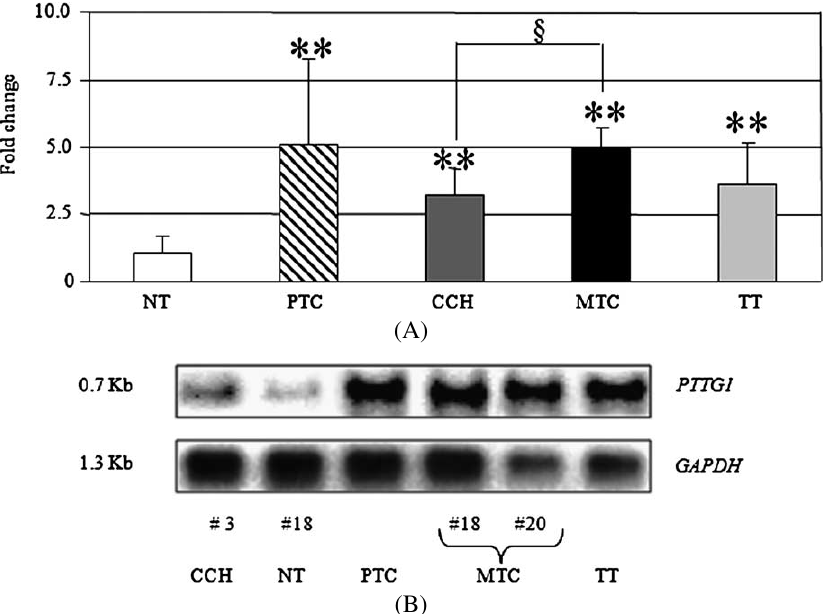
Fig. 1. Northern blot analysis of PTTG1 gene expression. (A) Northern blot analysis for PTTG1 mRNA expression in normal thyroid tissue (NT), 4 PTC, 8 CCH, 19 MTC and TT cells, expressed as fold changes vs. NT ± SE. ∗∗ p < 0 . 01, PTTG1 mRNA expression vs. NT; § p < 0 . 05, PTTG1 mRNA expression in CCH vs. MTC. NT – normal thyroid; PTC – papillary thyroid carcinoma; CCH – C-cell hyperplasia; MTC – medullary thyroid carcinoma; TT – TT cell line. (B) PTTG1 mRNA levels. Representative Northern blot analysis for PTTG1 and GAPDH expression in C-cell hyperplasia (CCH), normal thyroid (NT), papillary thyroid carcinoma (PTC), medullary thyroid carcinoma (MTC) samples and TT cells. Depicted results are representative of at least 3 different